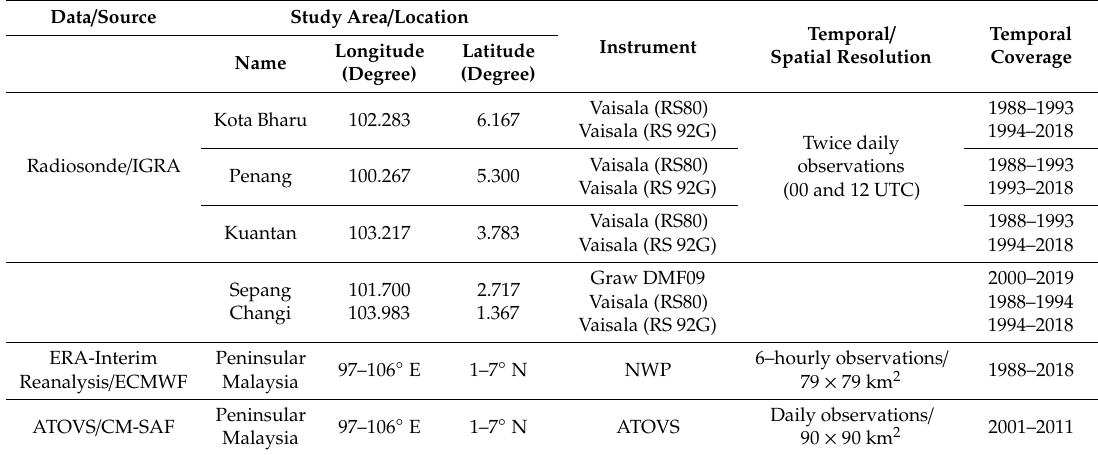
Table 1. Description of the datasets and their